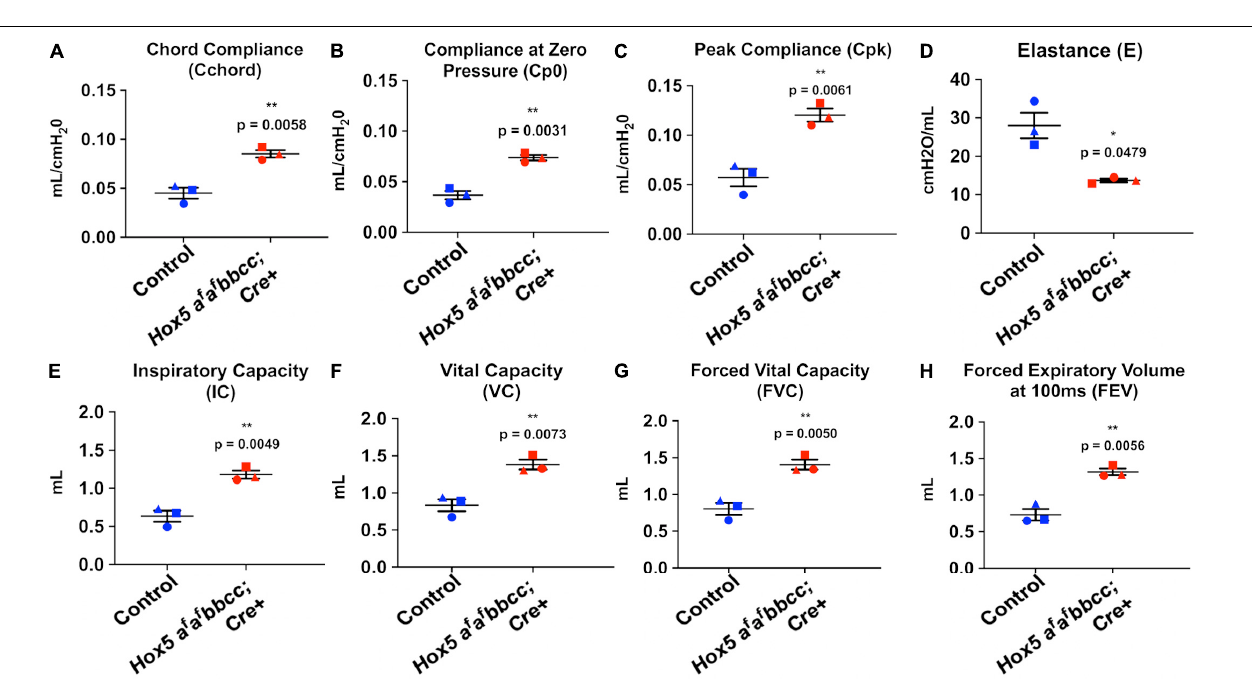
FIGURE 2 | Adult conditional Hox5 mutant lungs exhibit abnormal pulmonary function. Lung compliance, elastance and volume were measured in mice by fast flow maneuvers using orotracheal intubation and tracheostomy. Increased lung compliance of Dox-treated (8–10 weeks) Hox5 conditional mutants is indicated by significant increases in chord compliance (Cchord) (A) , compliance at zero pressure (Cp0) (B) , and peak compliance (Cpk) (C) . Hox5 adult conditional mutants also exhibit a significant decrease in elastance (E) (D) , and a significant increased lung volume indicated in inspiratory capacity (IC) (E) , vital capacity (VC) (F) , forced vital capacity (FVC) (G) , and forced expiratory volume (FEV) (H) . Each shape represents an individual animal. P -values and statistical significance (*0.01 ≤ P < 0.05; **0.001 ≤ P < 0.01) were determined by an unpaired Student’s t -test.